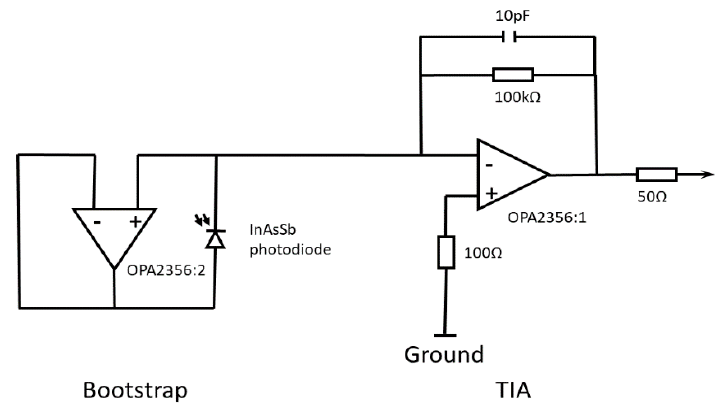
Figure 1. InAsSb photodiode bootstrapped transimpedance amplifier schematic.